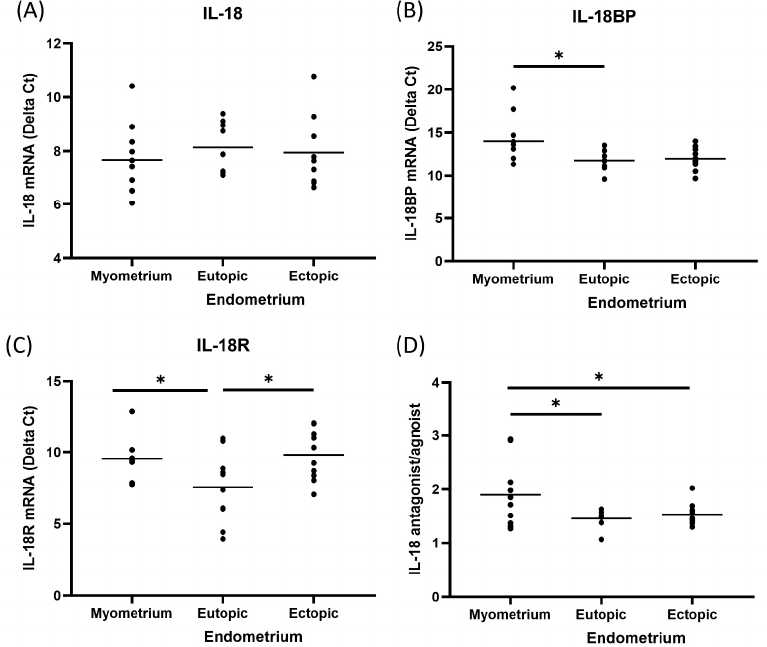
Figure 1. IL-18 mRNA determined by real-time quantitative PCR in paired tissue of patients with adenomyosis. According to C T value quantification and 2 −∆∆ Ct method, ( A ) IL-18 was similar among the tissues from eutopic, ectopic endometrium, and corresponding myometrium; ( B ) IL-18BP was significantly lower in corresponding myometrium than those in eutopic endometriu; ( C ) IL-18R was significantly lower in ectopic endometrium and corresponding myometrium in comparison to eu- topic endometrium; ( D ) an increased ratio of IL-18 antagonist to agonist in ectopic endometrium compared with corresponding myometrium is demonstrated that IL-18 system may play a critical role in regulating immune response and suppressing the rejection of eutopic endometrium implan- tation at the level of EMI. * p < 0.05.